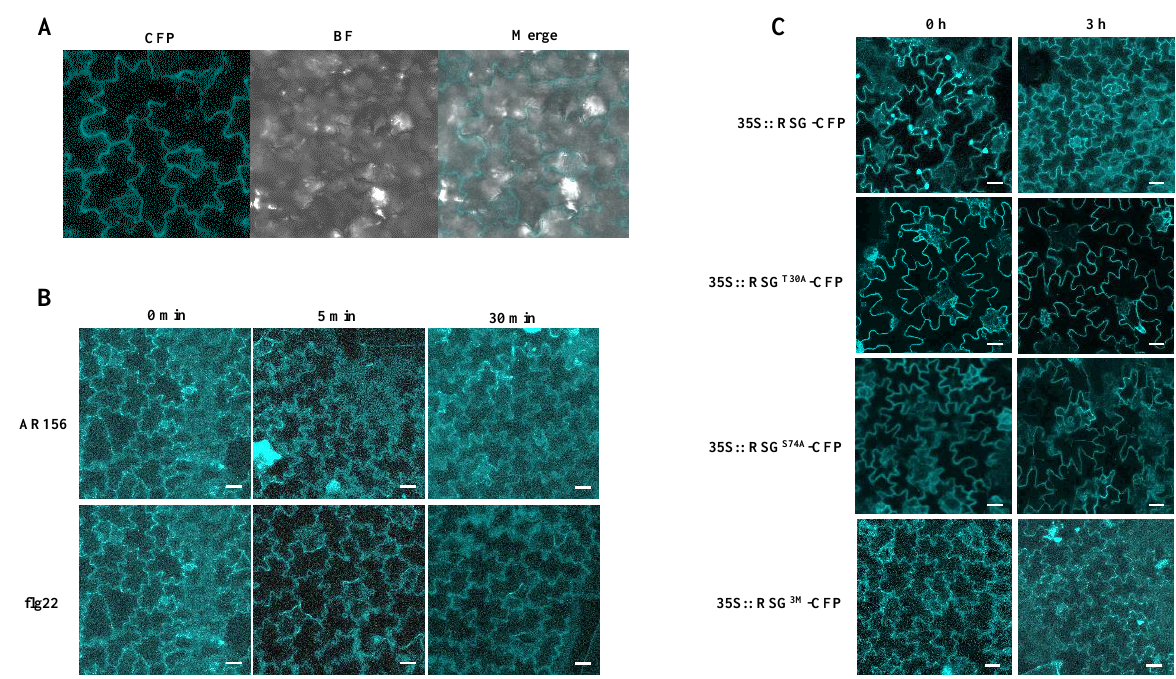
Figure 6. Mimic non-MAPK associated phosphorylation in RSG shows stable pre-dominant cytoplasm Figure 6. Mimicking non-MAPK-associated phosphorylation in RSG shows stable pre-dominant cyto- localization. (A) RSG 3M (T30D/S74D/T135D) tagged with CFP were transiently expressed in plasm localization. ( A ) RSG 3M (T30D/S74D/T135D) tagged with CFP were transiently expressed agroinfiltrated leaf epidermis of N. benthamiana , and analyzed by confocal microscopy three days post- infiltration. (B) RSG 3M (T30A/S74A/T135A) tagged with CFP were stably expressed in transgenic N. tabacum , and analyzed by confocal microscopy upon treatment of flg22 or B. cereus AR156 suspension. (C) Observation of transgenic tobacco overexpressed RSG, RSG T30A ,RSG S74A or RSG 3M fused with CFP upon treatment GA . RSG and indicated mutants tagged with CFP were stablely expressed in transgenic N. 3 CFP signal is in cyan.